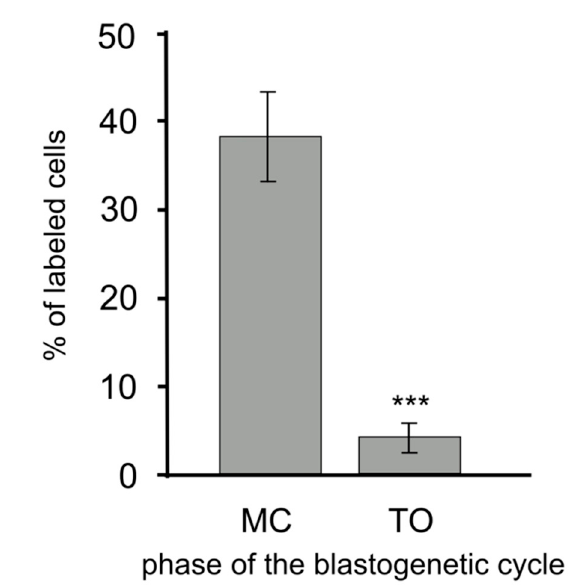
Figure 6. Fraction of hemocytes labeled by the riboprobes for bsc3a/c5ar at MC and TO. Asterisks indicate significant differences with respect to the control (***: p < 0.001).